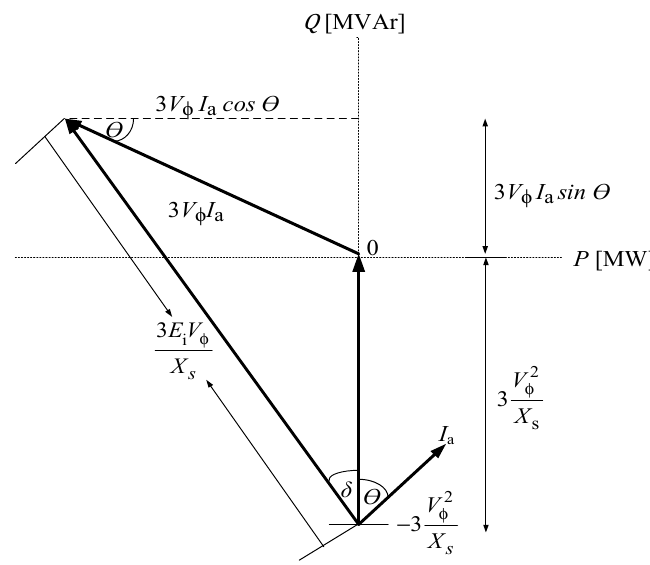
Figure 3. Plot of the phasor diagram in the power axis.